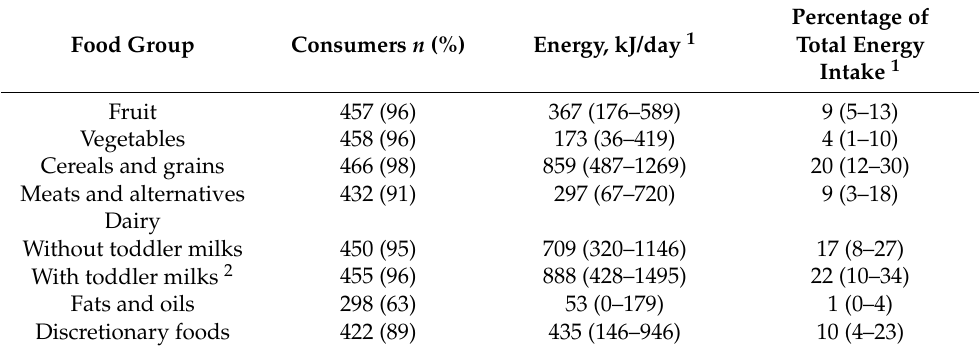
Table 4. Energy and percentage total energy from five food groups and discretionary foods for toddlers aged 12–24 months, OzFITS 2021 ( n =